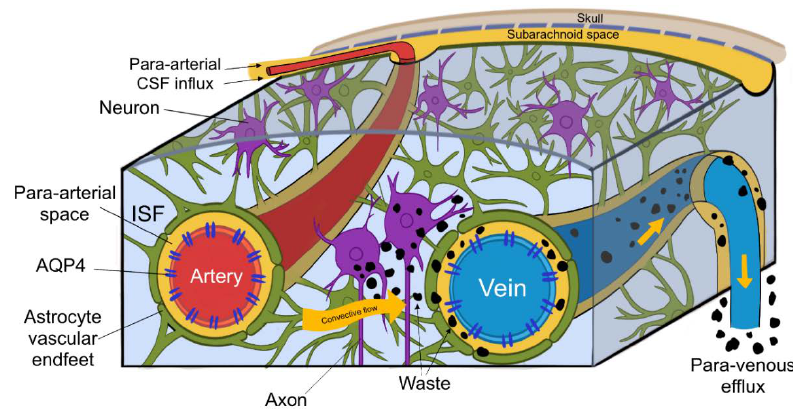
Figure 3. (Figure illustrated by Jessamyn Camille Reddy, adapted from; [2] p. 16) This figure